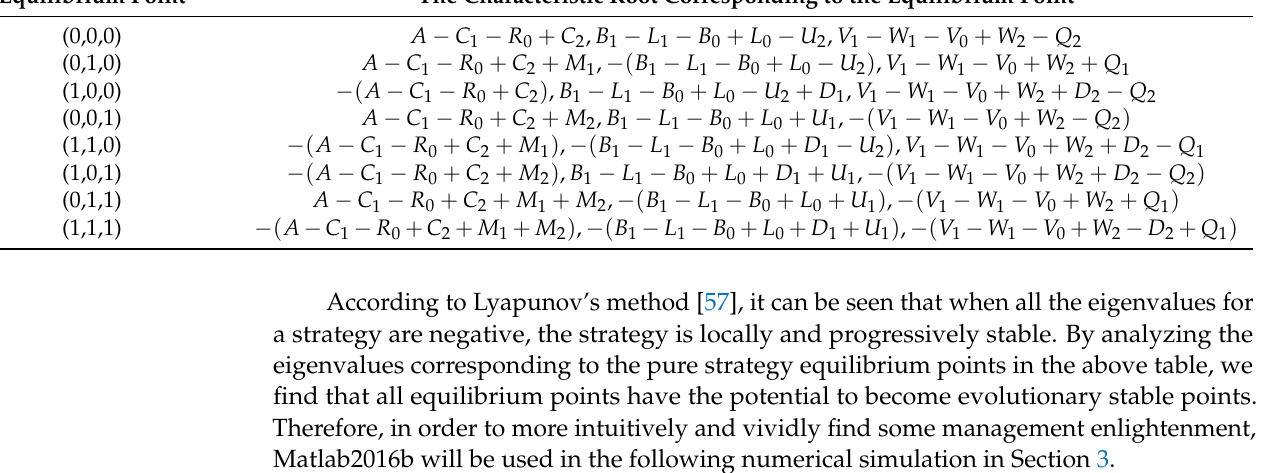
Table 2. The characteristic roots corresponding to the equilibrium point without government subsidies. Equilibrium Point The Characteristic Root Corresponding to the Equilibrium Point